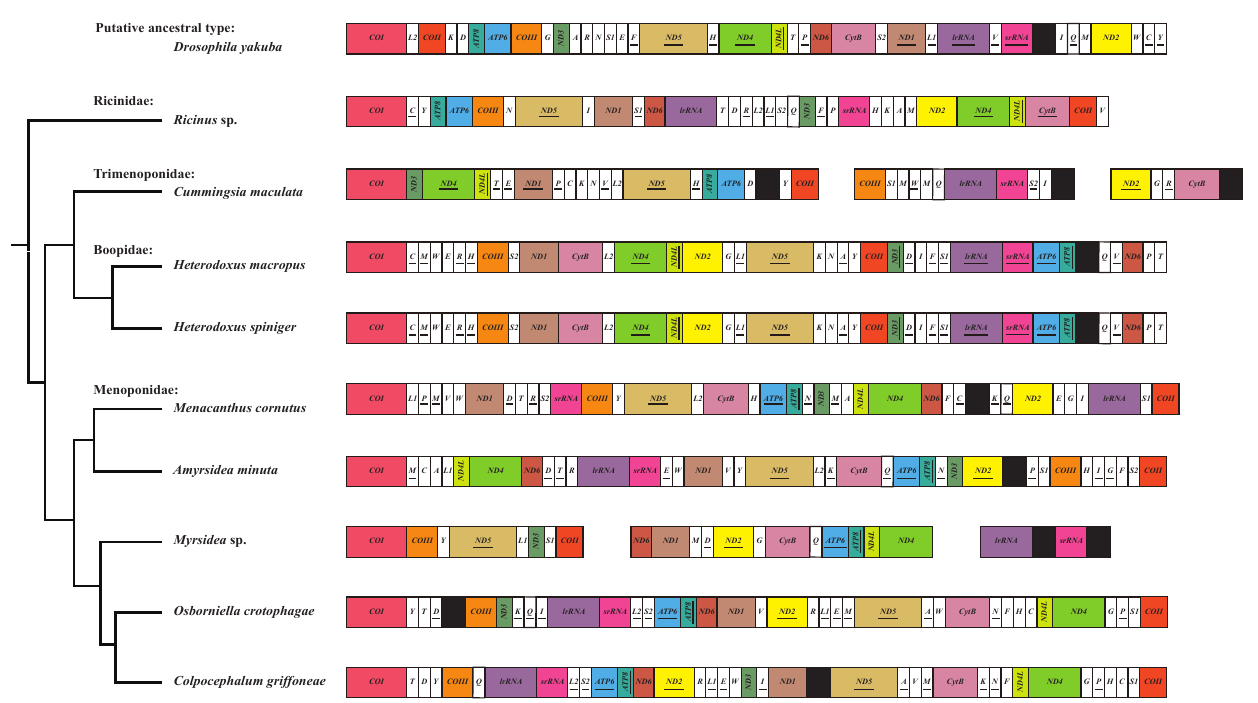
Figure 3. Gene arrangements of the Amblycera mitochondrial genomes. The mt genomes have been linearized for ease of comparison and arbitrarily begin with COI when possible. Different PCGs and rRNA genes are shown in different colors, with tRNA genes in white and control or non-coding intergenic regions in black. The gene names are the standard abbreviations used in this study. Underlined labels indicate the gene was transcribed from the minority